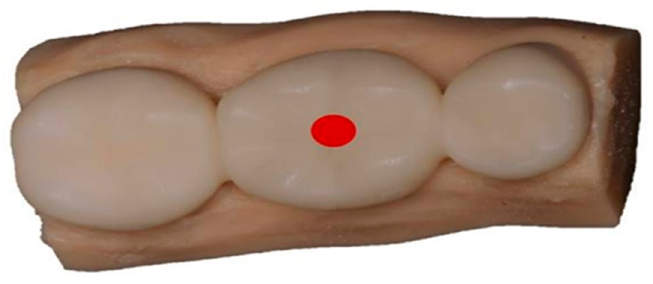
Figure 3. Location of metal jig of instron machine on the 3-unit IFDP sample (red circle on the central fossa of oclusal surface).